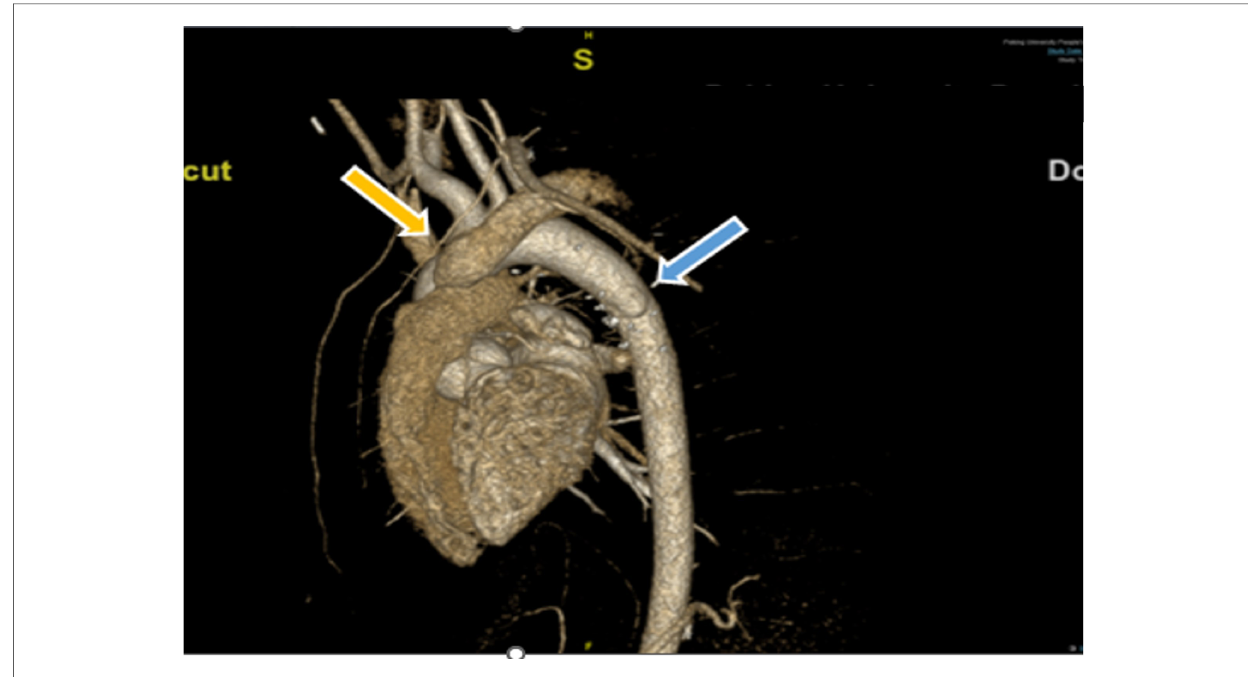
FIGURE 3 Postoperative volume-rendered cardiac CT angiography image. Repaired descending aorta with pericardium patch was showed as the blue arrow. AOLPA anastomosed to the main pulmonary artery via 18# synthetic vessel is indicated by the yellow arrow. AOLPA, anomalous origin of the left pulmonary artery; CT, computed